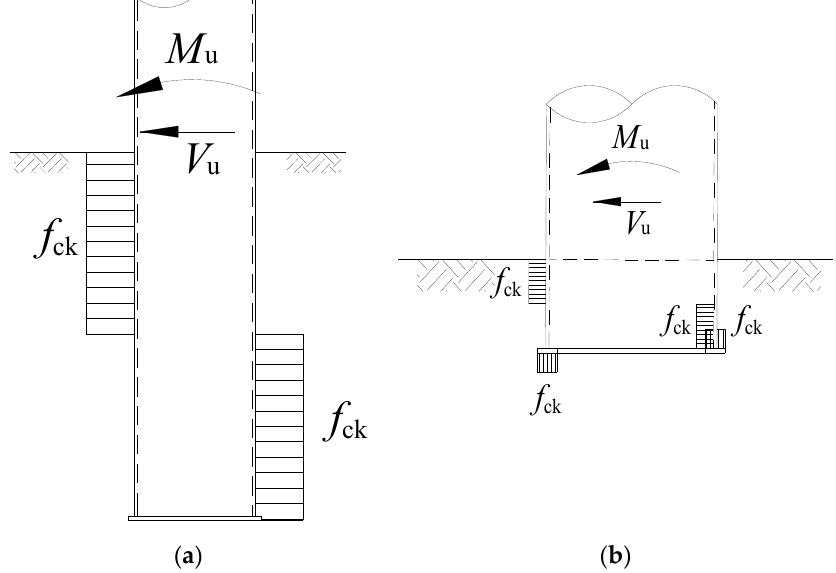
Figure 2. Transfer mechanism of the ultimate bending capacity for an embedded foundation. ( a ) Steel insert column; ( b ) Steel insert ring.